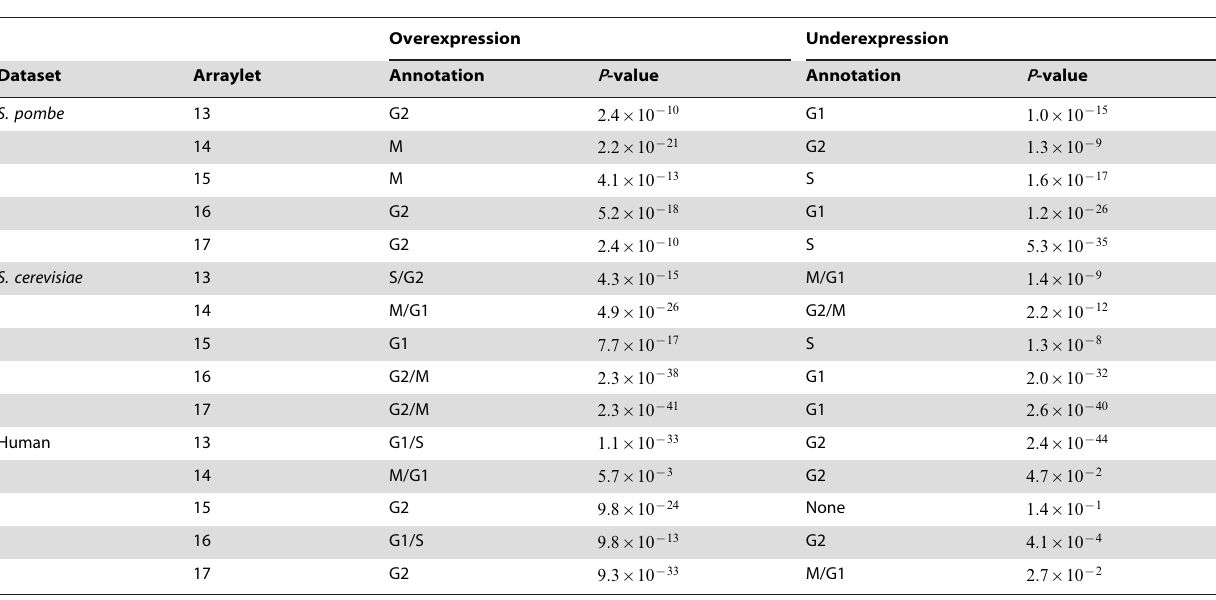
Table 1. Arraylets or left basis vectors.